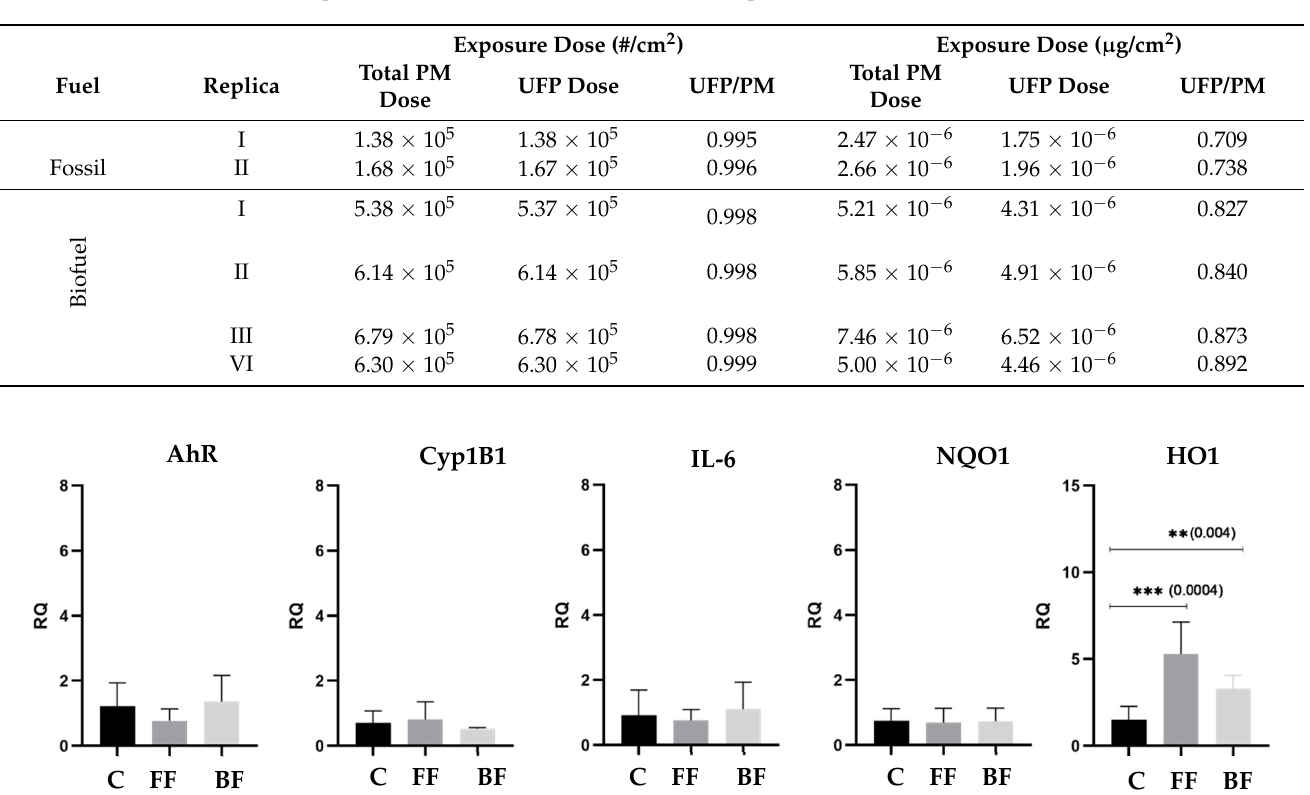
Table 8. In vitro model doses of exposure. Doses are reported as number of particles and mass of particles deposited per square cm of cell surface. The relative contribution of ultrafine particles (UFP, particles with diameter < 100 nm) is also reported.